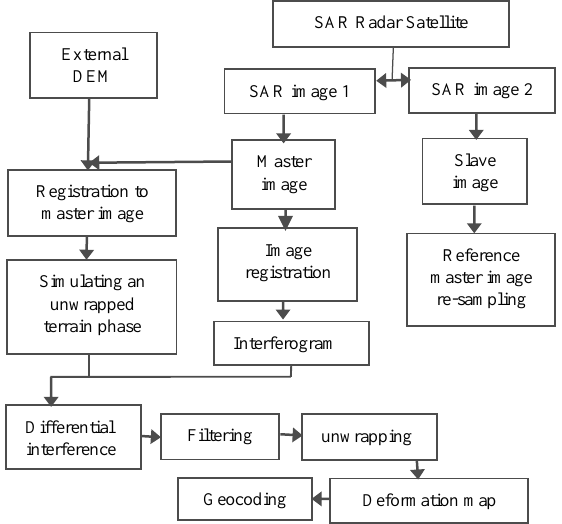
Figure 3. Flowchart of Two-pass DInSAR